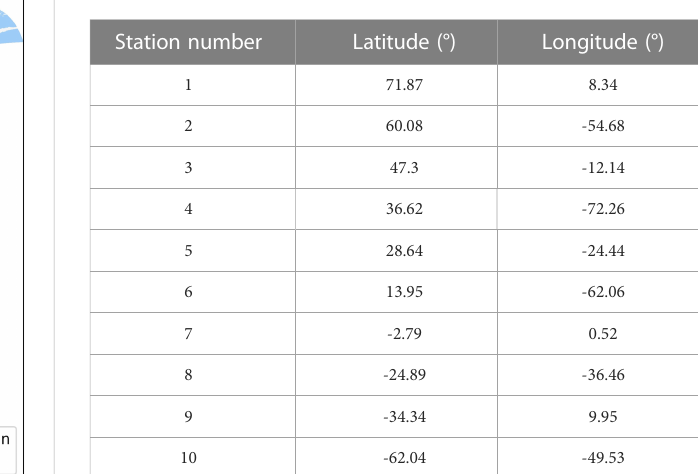
TABLE 1 Locations of sample stations in the Atlantic Ocean used in this study.